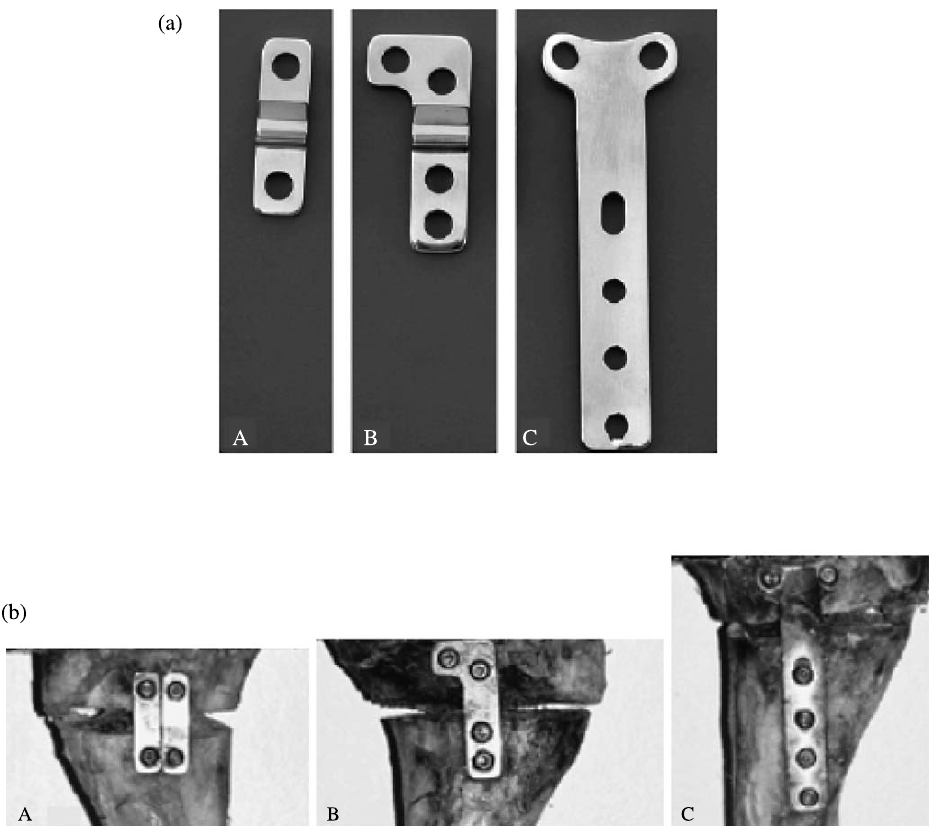
Fig. 5. Osteotomy fixation plates [9]. a. Appearance of the internal surface of plates. b. Mounted forms of plates on the bone. A: Rectangular shaped two-holed plate with wedge. B: Reversed “L” shaped four-holed plate with wedge. C: Anatomical “T” plate with 6 holes.